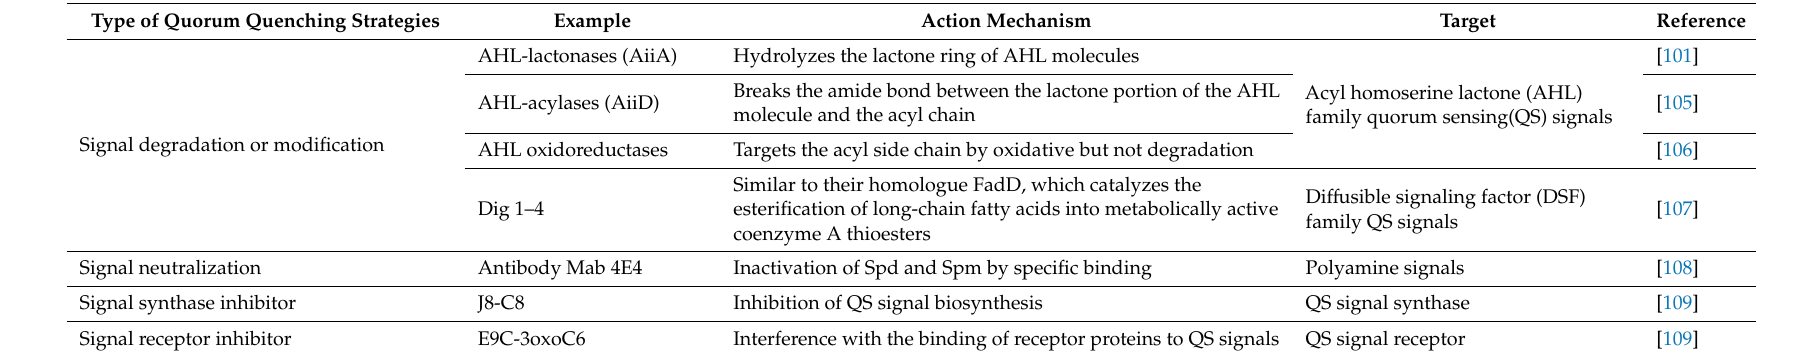
Table 1. Strategies for blocking microbial cell-cell communication